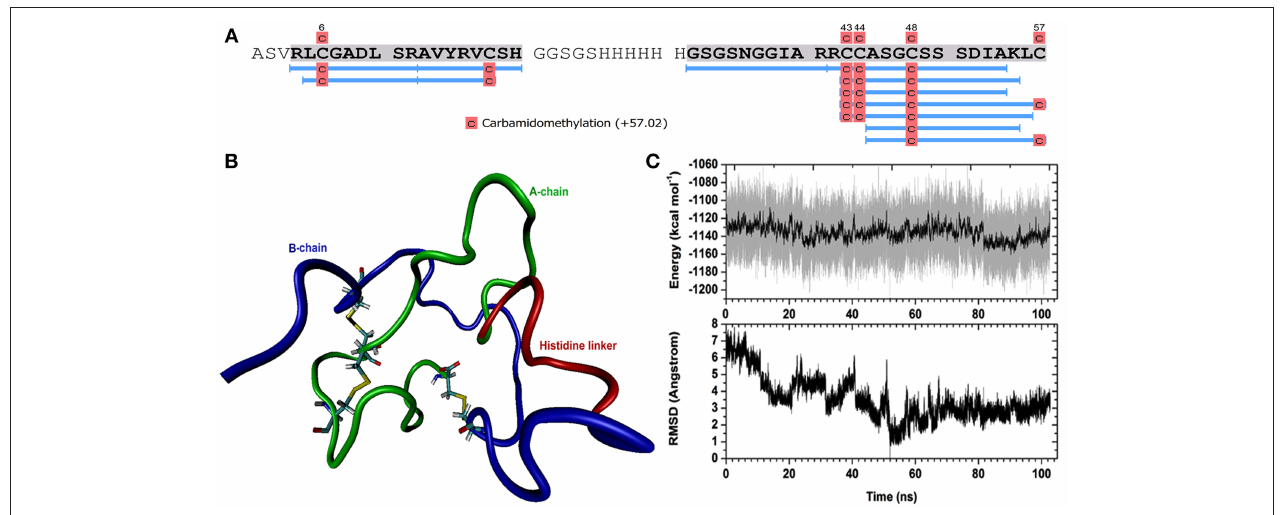
FIGURE 3 | Recombinant Holothuria scabra RGP and mass spectrometry (MS) identification. (A) RGP sequence showing MS peptide coverage (light blue lines). (B) A representative structure of recombinant RGP. Green: A-chain, dark blue: B-chain, red: histidine linker “GSGSHHHHHHGSGS”. (C) Upper, potential energy of RGP peptide as a function of time during molecular dynamics (MD). Lower, backbone RMSD (root mean square deviation) during the same MD, compared to the lowest-energy conformation (the representative